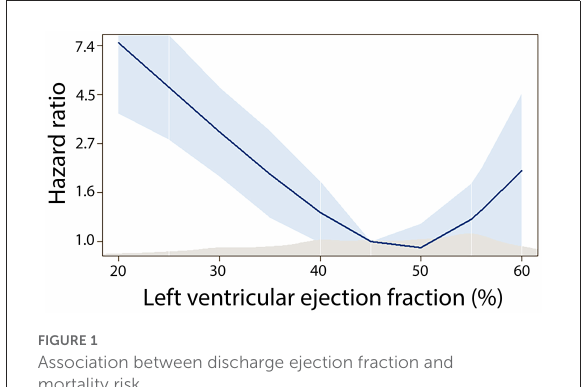
FIGURE1 Association between discharge ejection fraction and mortality